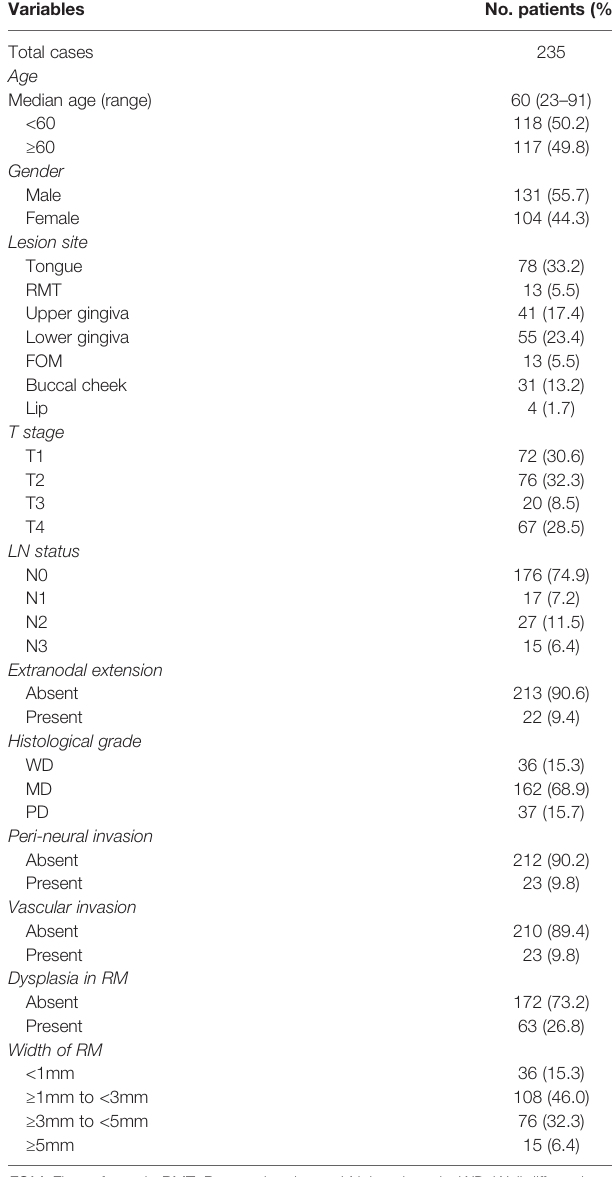
TABLE 1 | Clinicopathologic characteristics of 235 OSCC patients. Variables No. patients